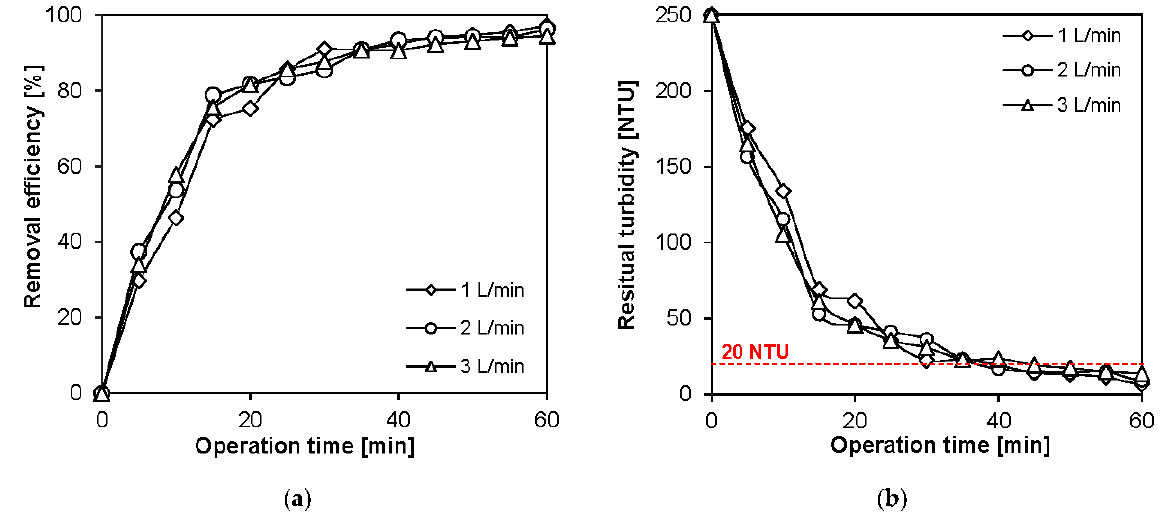
Figure 12. Turbidity removal at different liquid flows: ( a ) removal efficiency and ( b ) residual tur- bidity.